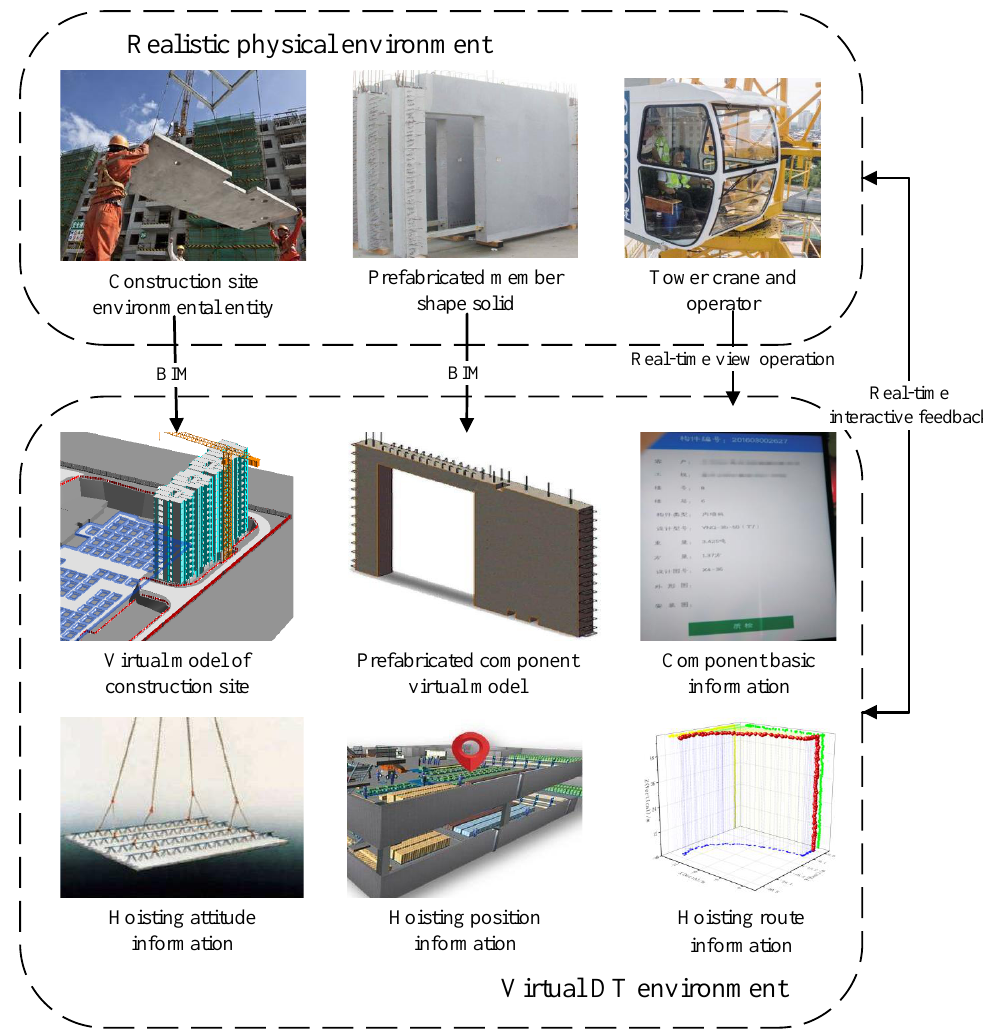
Figure 2. Framework of hoisting control method based on